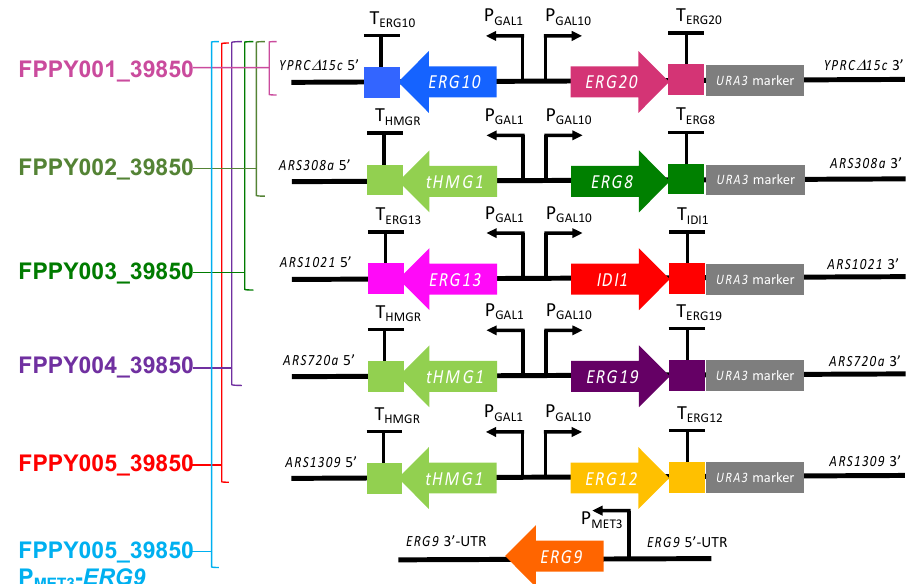
Figure 2. Pathway design for the construction of FPP-overproducing S. cerevisiae strain. Block arrows designate mevalonate pathway genes; block squares are endogenous terminators; thin arrows are endogenous promoters; grey rectangles are native auxotrophic selectable markers (the URA3 selectable marker is flanked by loxP sites). The integration sites ( YPRC Δ 15c , ARS308a , ARS1021 , ARS720a , and ARS1309 ) for the gene constructs are marked.